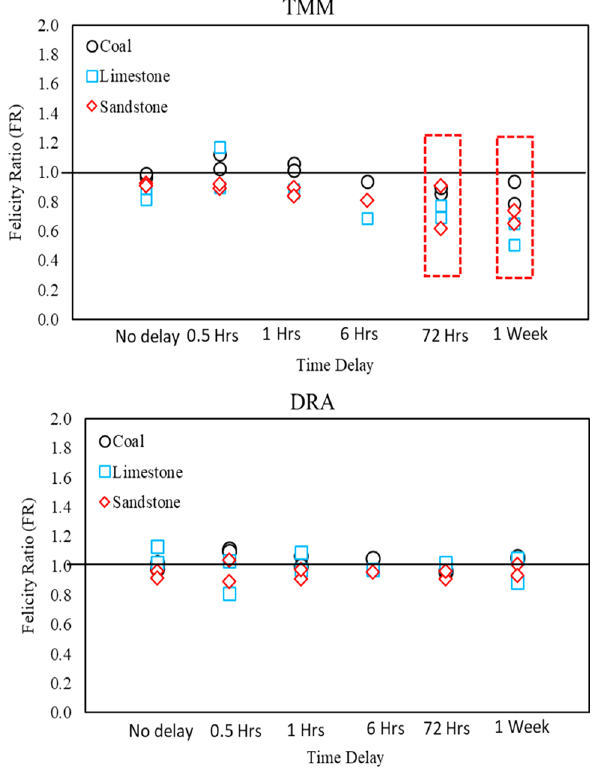
Fig. 16 Comparison of FR using TMM and DRA method showing influence of time delay on